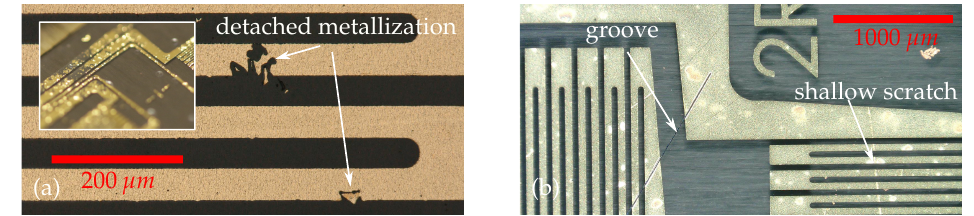
Figure 8. ( a ) Micrograph of an interrupted measuring grid after lithografic structuring on the untreated foil substrate. Insert shows picture of larger detached metallization flakes. ( b ) Micrograph obtained with ring light illumination allows to distinguish between function disturbing grooves and superficial scratches.